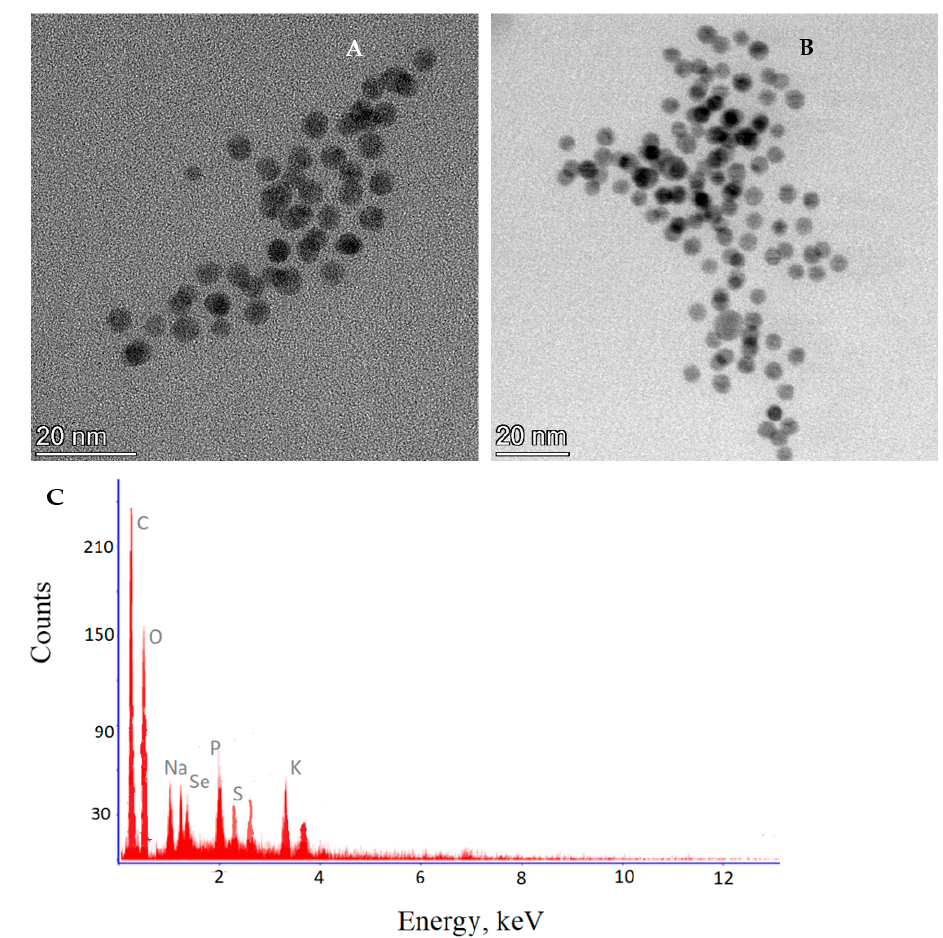
Figure 3. SeNPs in protein fraction (( A )—camera imaging 634.1 kx Ceta; ( B )—STEM diffraction 802.3 kx BF, ( C )—EDX spectra of selenium nanoparticles) . kx BF, ( C )—EDX spectra of selenium